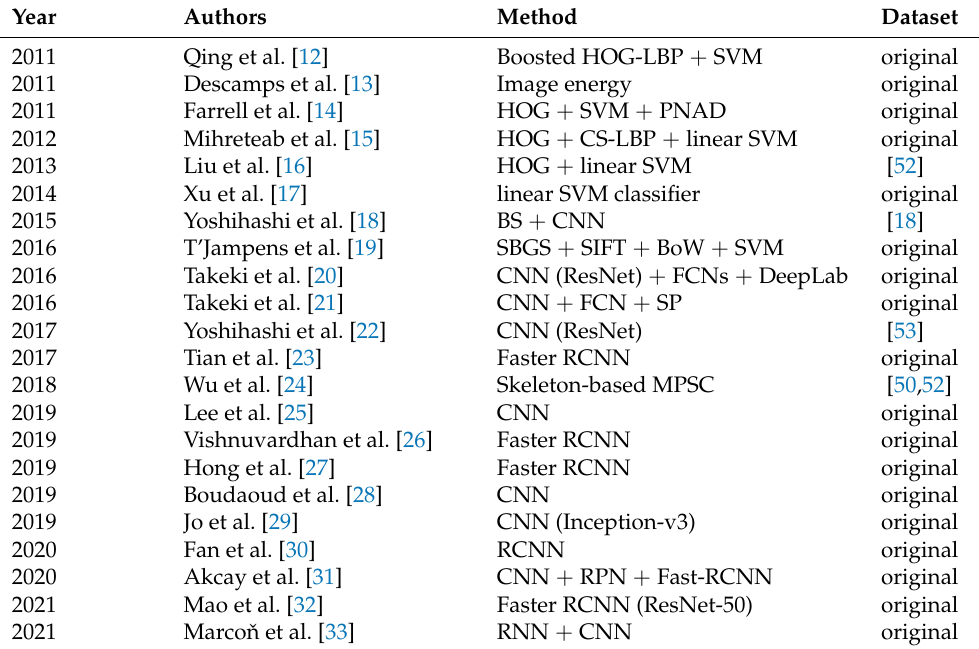
Table 1. Representative studies of vision-based bird detection methods reported during the last